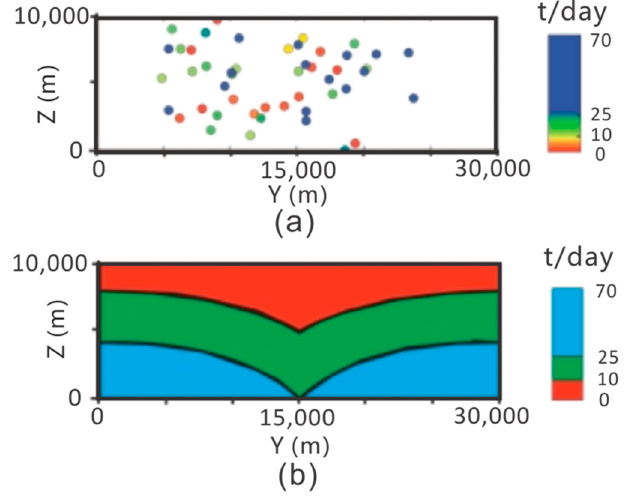
Figure 8. A comparison of the spatiotemporal distribution of aftershocks and the numerical simula- tion of the fault reactivation area. ( a ) The aftershock distribution at different times. ( b ) The calculated fault reactivation area at different times.